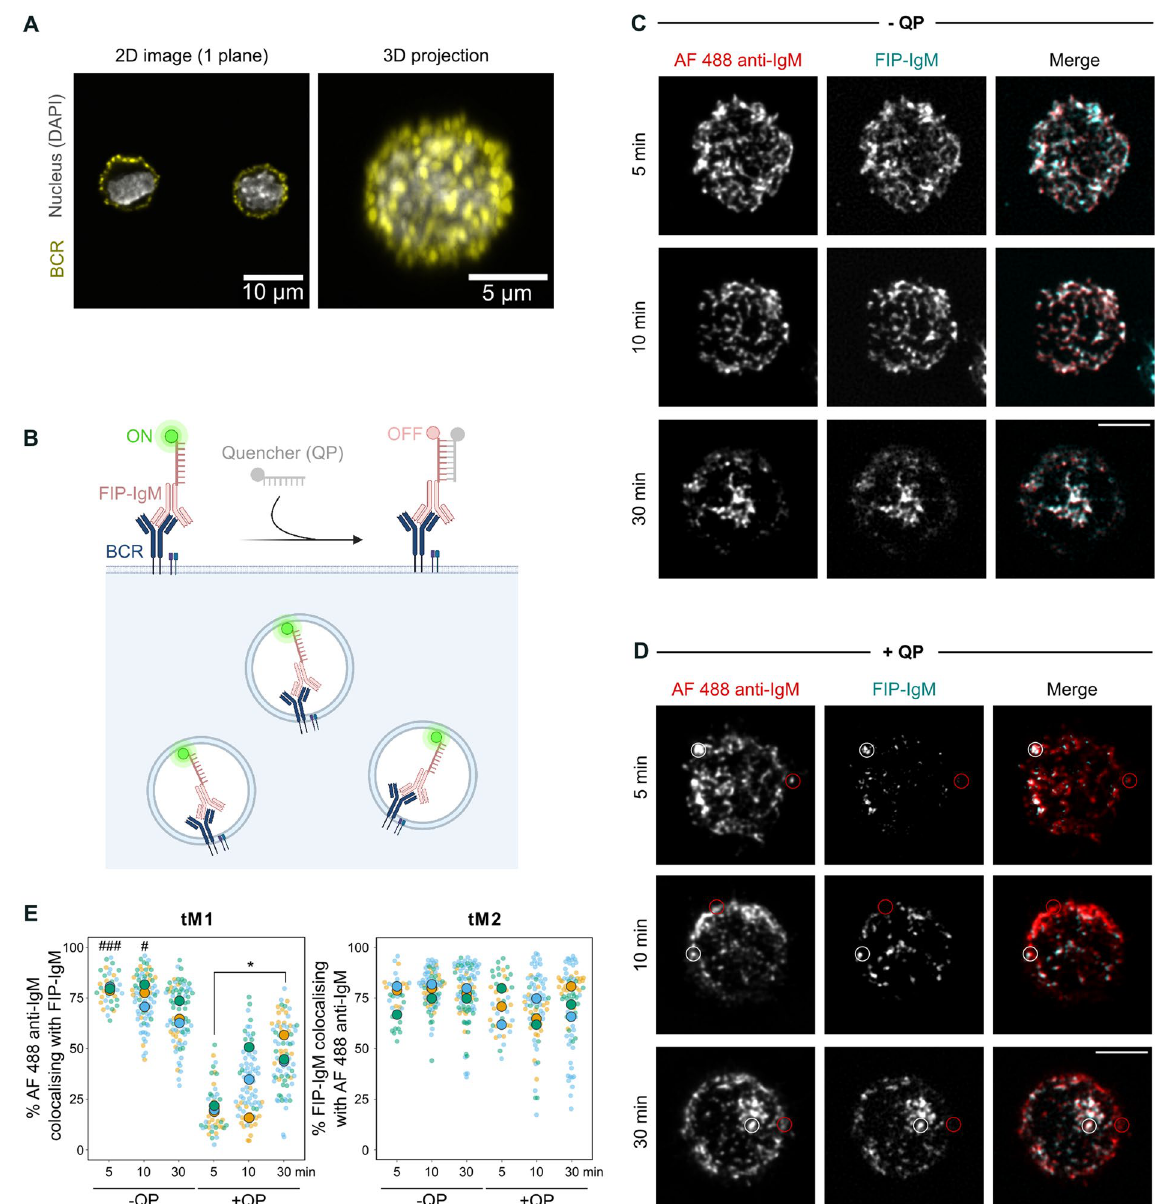
Figure 1. The SHIP assay can be used to track antigen internalization in B cells. ( A ) A20 D1.3 B cells imaged with a SDCM. Cells were stained on ice with AF488 anti-IgM to visualize the surface-bound BCR, fixed and stained with DAPI (nucleus). ( B ) Schematic of the SHIP assay. B cells are incubated with FIP-IgM as a surrogate antigen to label and activate the BCRs. B cell activation will trigger antigen/BCR internalization. After QP addition, the surface-bound probes are quenched and only the signal from the internalized antigen will be detected. ( C , D ) B cells were stained with ATTO-FIP-IgM and anti-IgM Alexa Fluor 488, and activated at different time points. After activation, cells were incubated with ( C ) PBS or ( D ) QP for 10 min and fixed. Images were acquired using a SDCM. A representative image of one cell (stack, sum intensity projection) is shown. White and red circles mark examples of internalised and non-internalised antigen, respectively. Scale bar: 5 µm. ( E ) Colocalisation analysis of the images shown in C-D. Images were deconvoluted with Huygens and colocalisation was measured using Mander’s overlap coefficients (tM1 = % of the anti-IgM Alexa Fluor 488 signal colocalising with ATTO-FIP-IgM signal; tM2 = % of the ATTO-FIP-IgM signal colocalising with anti-IgM Alexa Fluor 488 signal). Different colours represent independent experiments (n = 3): the mean of each experiment is shown with large symbols, and small symbols show the measured cells. Statistics were calculated using the mean of each experiment (n = 3) and a paired t-test (* P < 0.05; # P < 0.05 vs 10 min + QP; ### P < 0.001 vs 5 min +